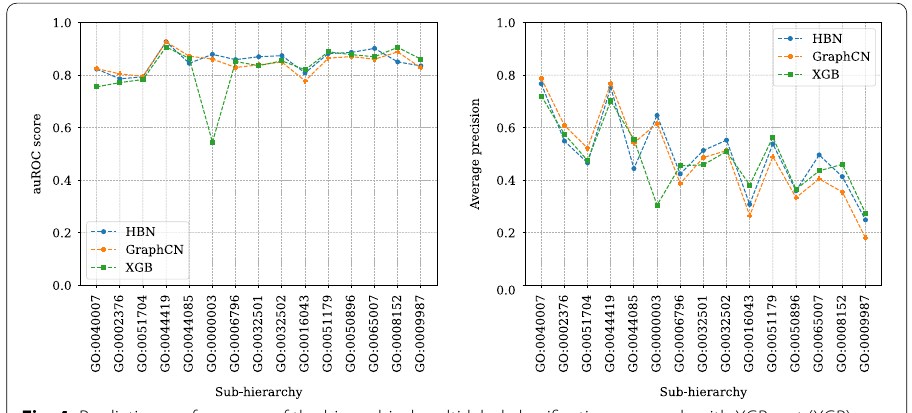
Fig. 4 Prediction performance of the hierarchical multi-label classification approach with XGBoost (XGB) and graph convolutional network (GraphCN) classifiers, and the probabilistic model (HBN) for the 15 sub-hierarchies of Oriza sativa Japonica . Performance is measured with area under the ROC curve and the average precision score. Note that the notation used for the graph convolutional network is GraphCN to distinguish it from the gene co-expression network